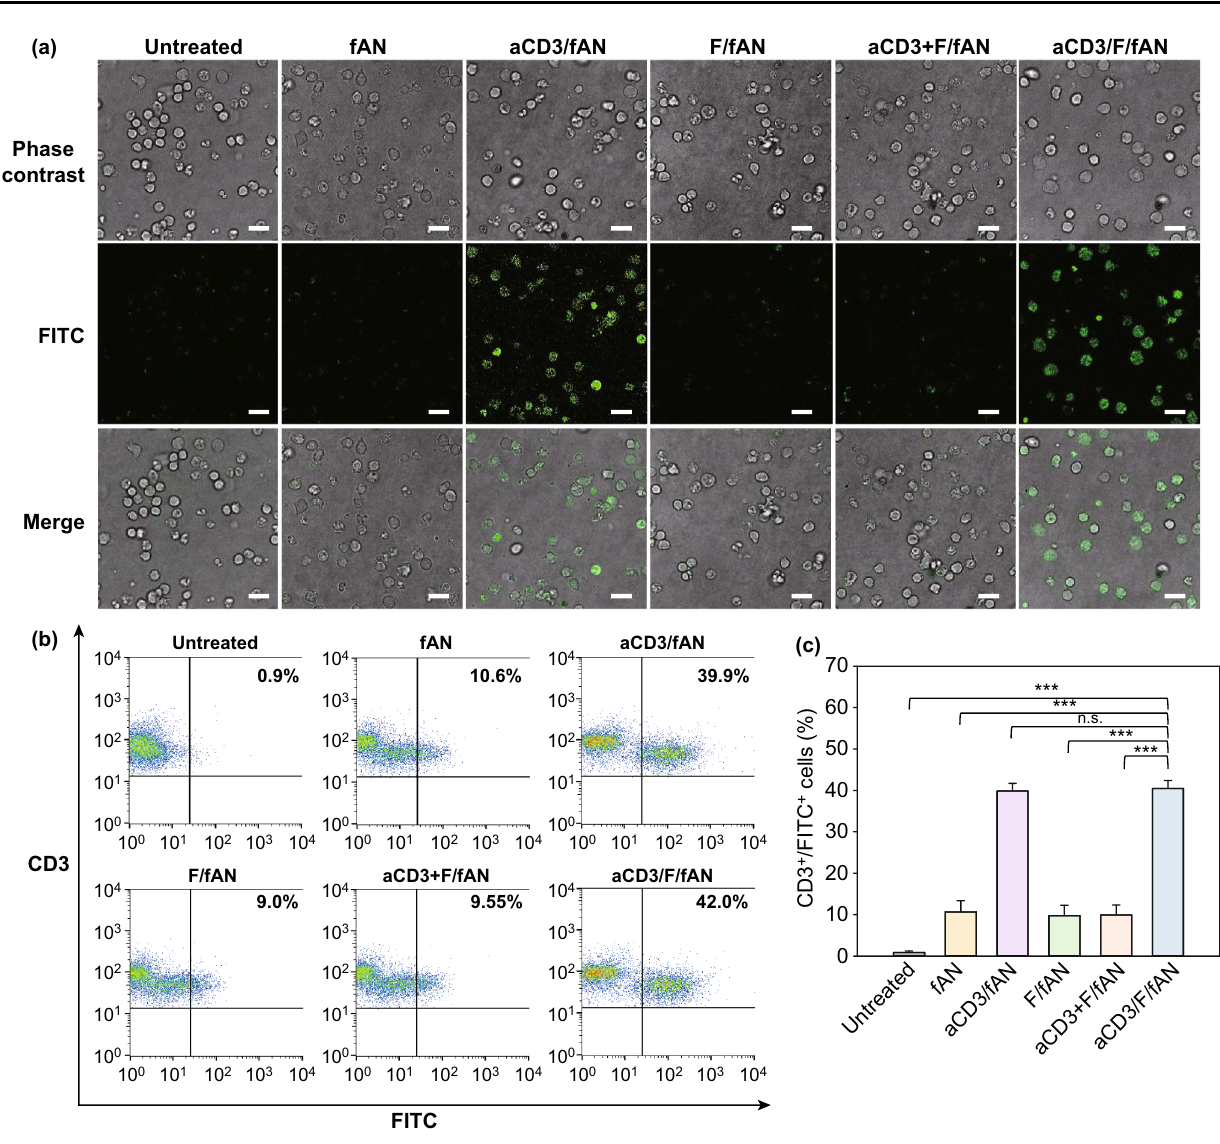
Fig. 3 Uptake of nanoparticles by T cells. Mouse spleen‑derived T cells were incubated with various fenofibrate‑containing nanoparti‑ cle preparations. After 24 h, cellular uptake of nanoparticles was visualized by confocal microscopy a and quantified by flow cytometry b, c (***P < 0.001, n.s., not significant). Scale bar: 10